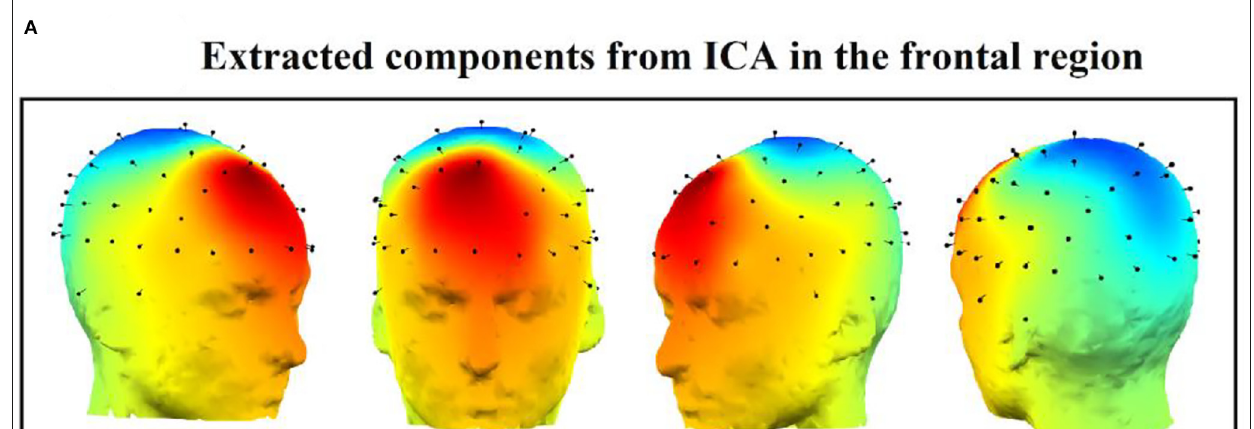
FIGURE3 Application of ICA on EEG after rTMS treatment. (A) Extracted components from ICA in the frontal region. (B) Extracted dipole from ICA in the frontal region. (C) Extracted components time-series from ICA in the mentioned region.